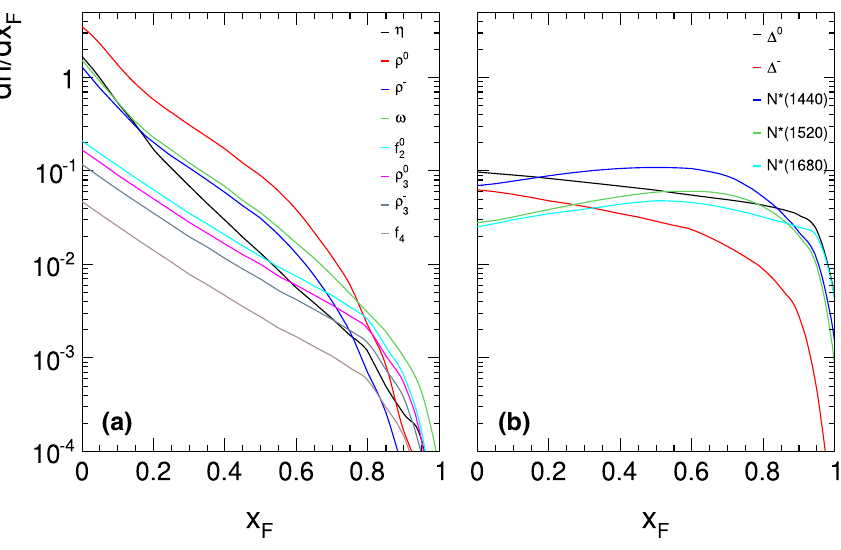
Fig. 181 dn / dx F distributions as a function of x F , (a) for a set of 8 mesonic resonances (b) for five baryonic resonances